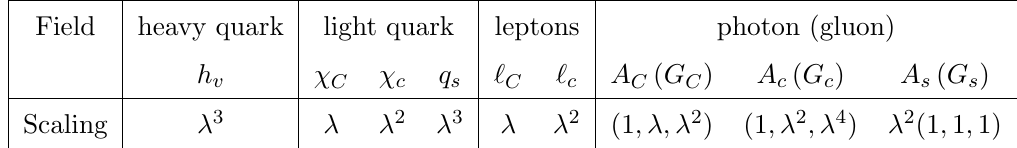
Table 1. Fields and their power counting in SCET. In addition there are anti-hard-collinear ( (cid:31) , C ‘ ) and anti-collinear ( (cid:31) c , ‘ c ) quark and lepton (cid:12)elds with the same scaling as their (hard)-collinear C counterparts. The components for the photon (cid:12)eld are ( n + A; A (cid:22) ; n (cid:0) A ) and the gauge-invariant ? (cid:22) (cid:22) building blocks and scale as the -components of the (cid:12)elds A C ? (cid:21) and A c ? (cid:21) 2 , C ? c ? A A ? (cid:24) (cid:24) respectively. The light quark and lepton masses scale as m q;‘ (cid:21) 2 (cid:24)